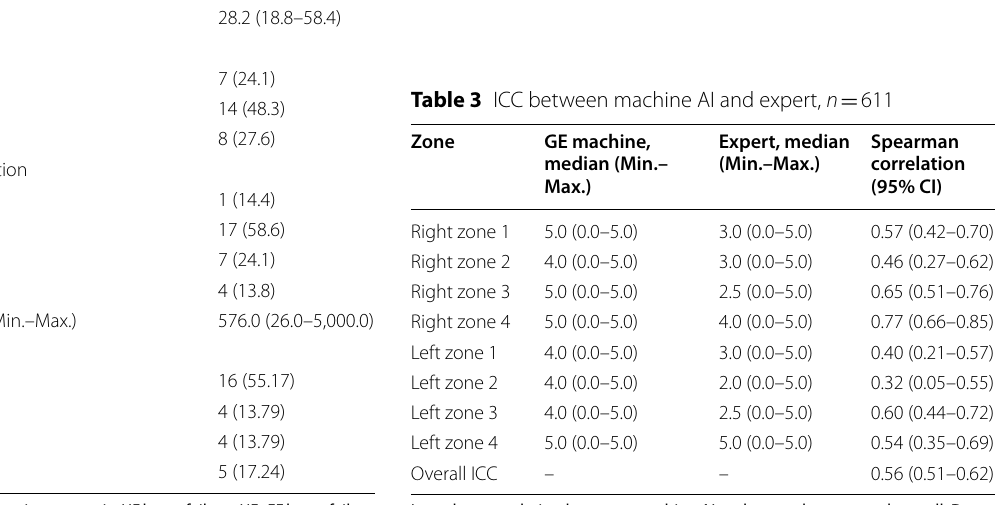
Intraclass correlation between machine AI and expert by zone and overall. Data are based off of 611